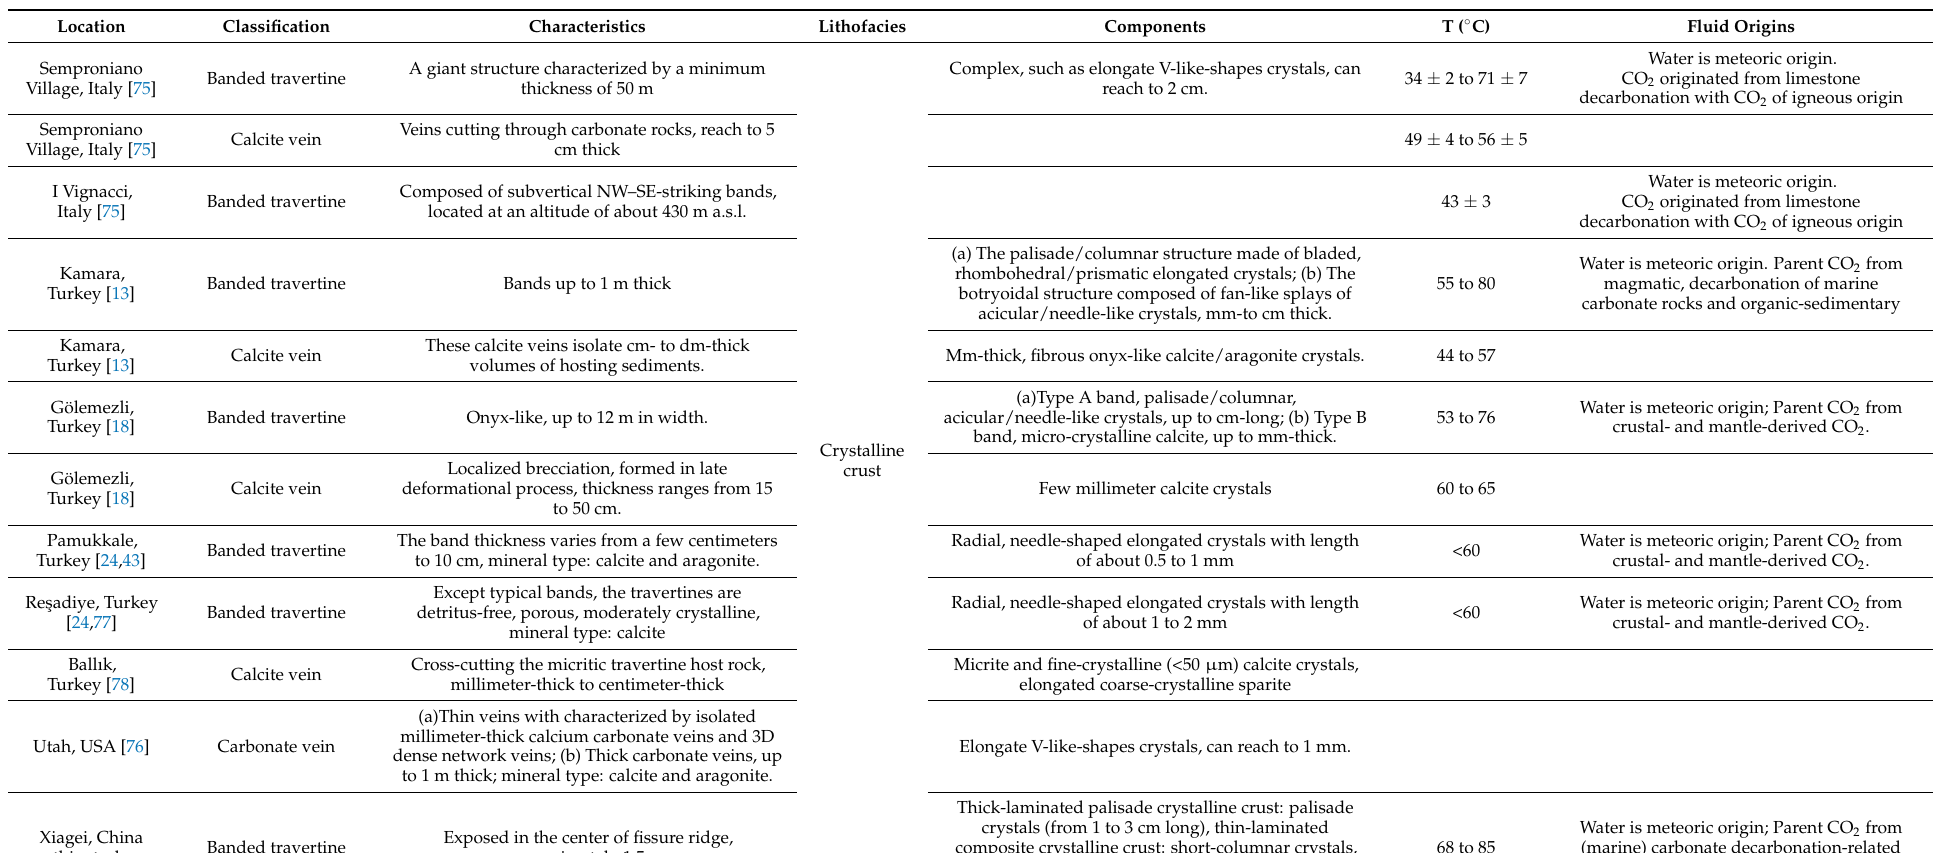
Table 3. Comparison of banded veins from Xiagei and those from other places. Except Pamukkale and Re¸sadiye, the calculated temperature of other locations and Xaigei using the equation from Kele et al. [39]. Blank = no